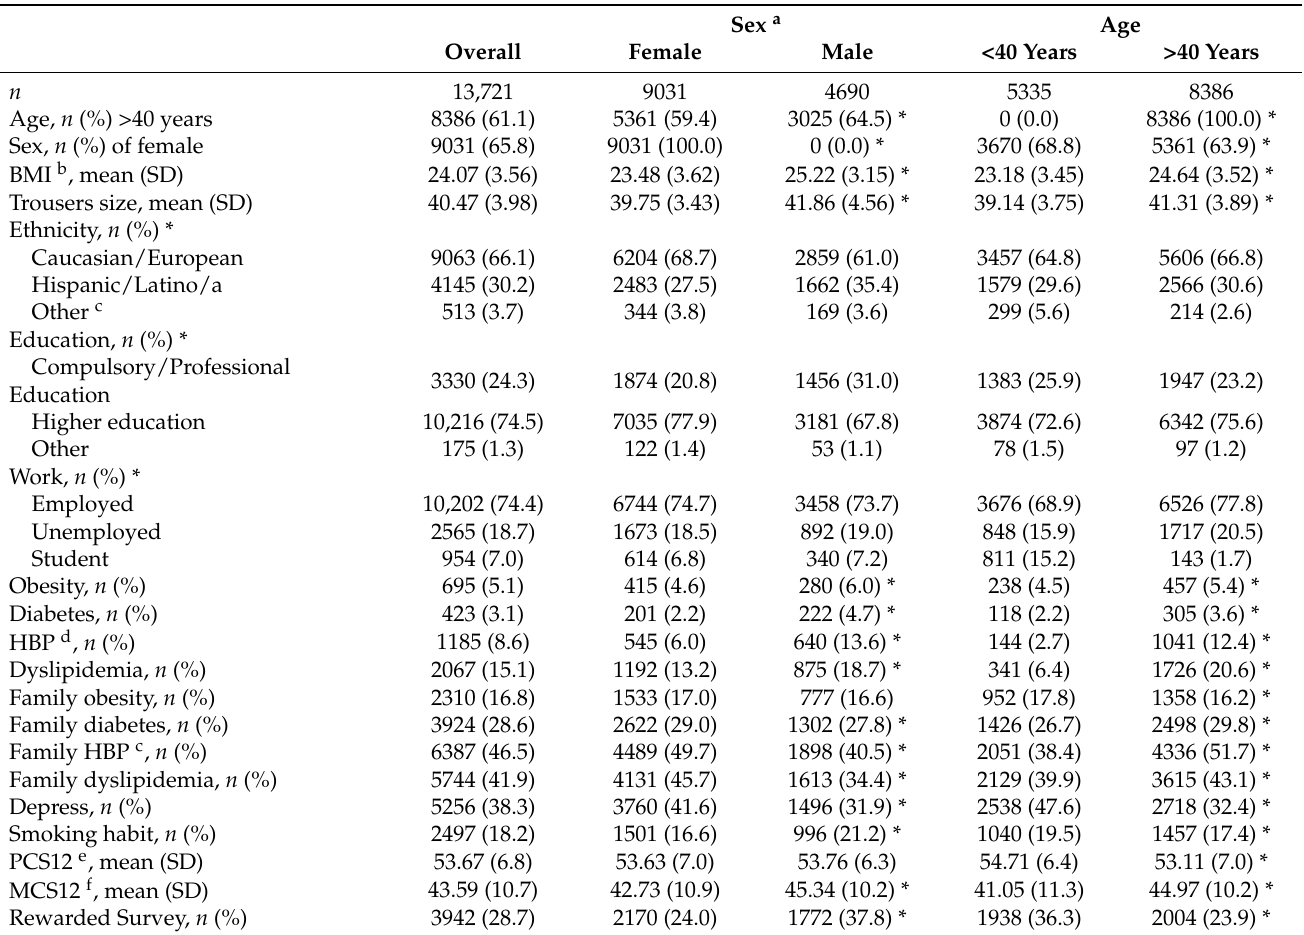
Table 1. The characteristics of the participants in the NUTRiMDEA online study according to clinical and sociodemographic variables categorized by sex and